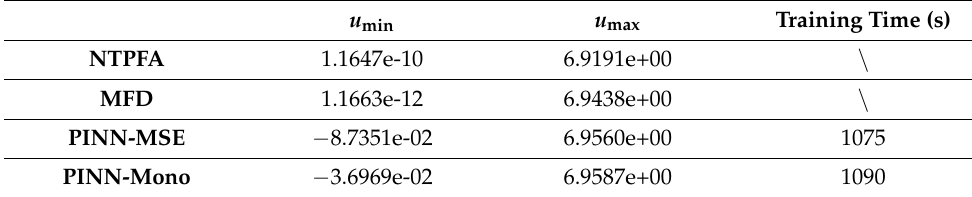
Table 3. Summary of computational results for case 2: k r = 10.